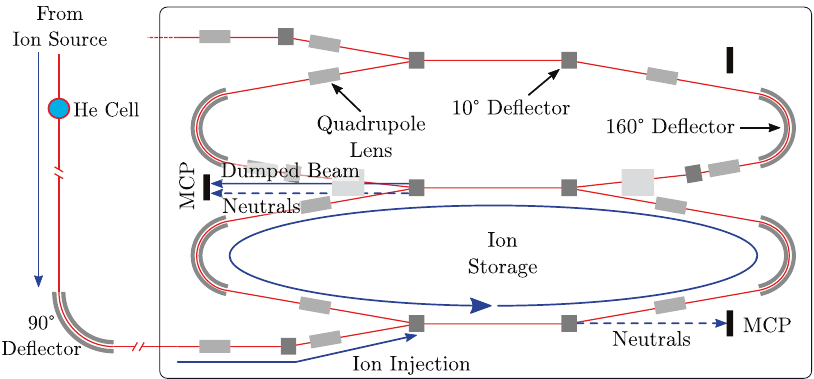
Fig. 6 Overview of the experimental setup. Mass-selected coronene cations with kinetic energies of 8 keV are passed through a gas cell containing a dilute He gas in order to induce fragmentation in a small fraction of the C 24 H þ ions that pass the cell. Selected fragments (C 23 H þ x or C 22 H þ x ) or intact ions 12 (C 24 H þ ) are stored (in separate measurements) in one of the DESIREE rings for stability measurements. The electrostatic beamline elements are indicated 12 by gray boxes that are labeled in the upper ring. Only the lower ring is used in these experiments. Neutral products formed along the two straight sections are detected by microchannel plate (MCP) detectors. The cryogenic region is indicated by the thin black line enclosing both rings.